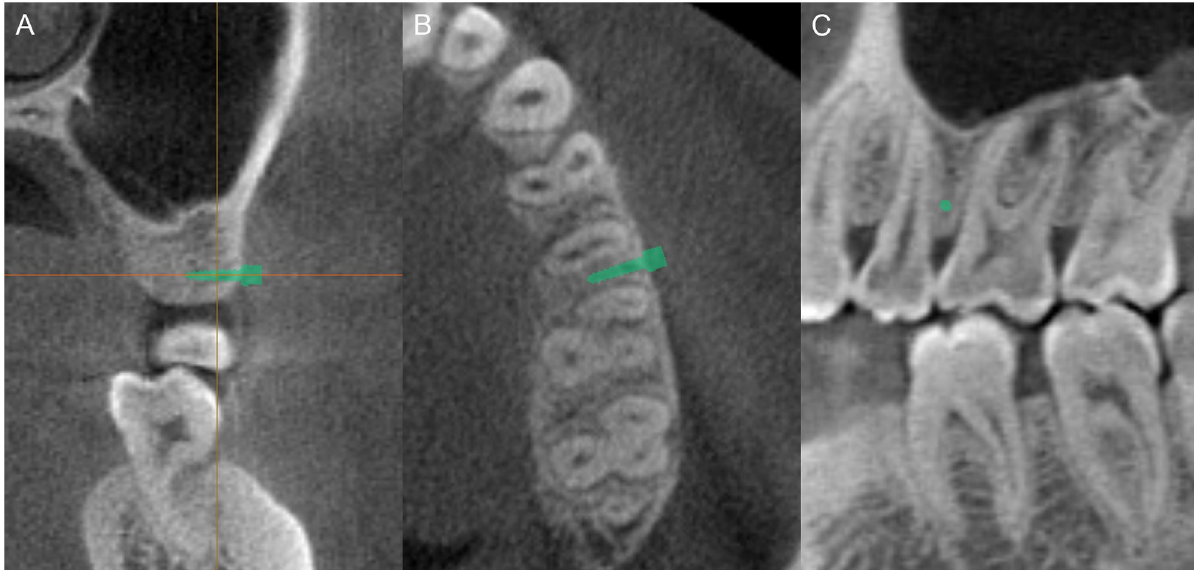
Fig 3. Miniscrew placement. (A) The long axis of the miniscrew should be parallel to the horizontal axis of the software. (B) The miniscrew is then placed at the mesiodistal midpoint between the roots in the axial view. (C) The miniscrew is seen as a circular dot in the sagittal view.